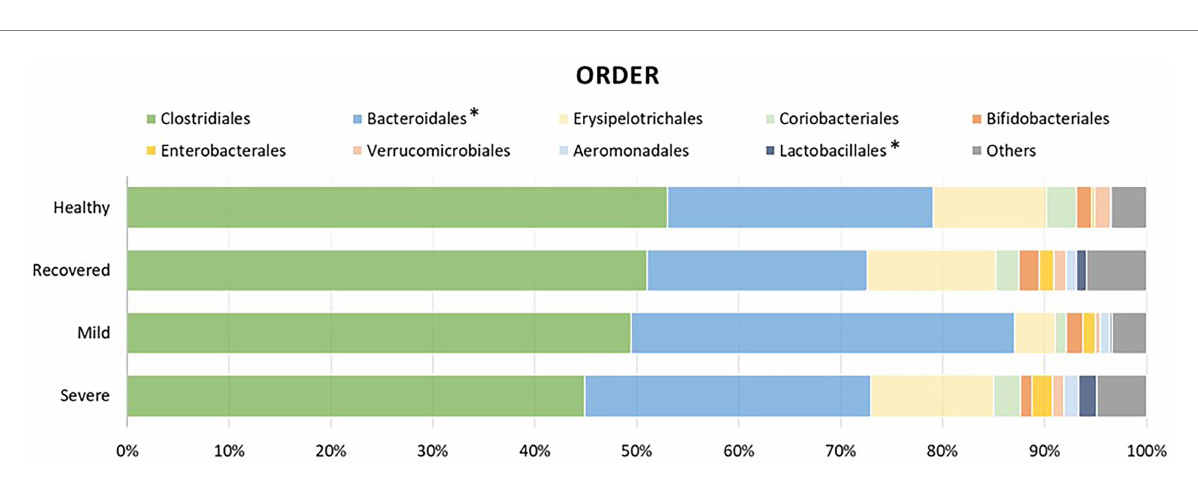
FIGURE 2 Relative abundance of the most prevalent bacterial orders between the different groups of this study: healthy volunteers, recovered patients, and COVID-19 infected patients with mild or severe symptoms. The asterisk symbol represents the statistically significant taxonomic